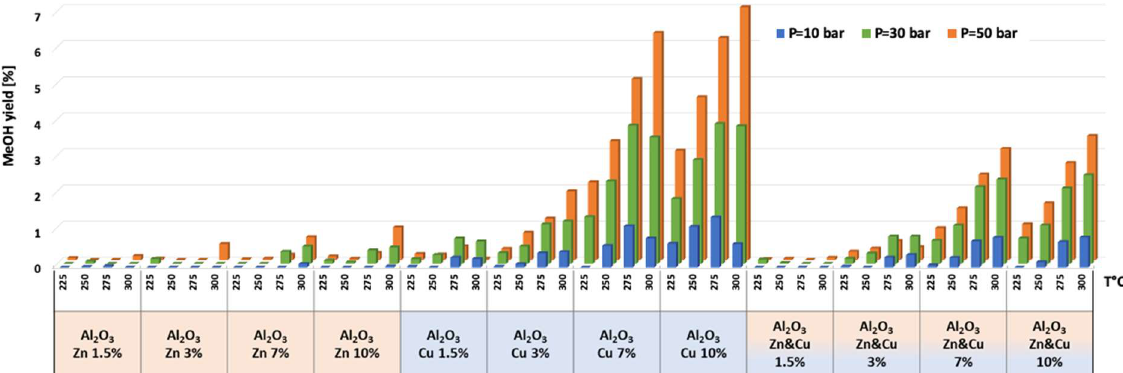
Figure 6. Selectivity to CH 4 , CO, DME, and methanol for AlNFs-Cu catalyst containing 10wt.% of Cu at pressures of 10, 30, and 50 bar and temperatures of 225, 250, 275, and 300 °C.